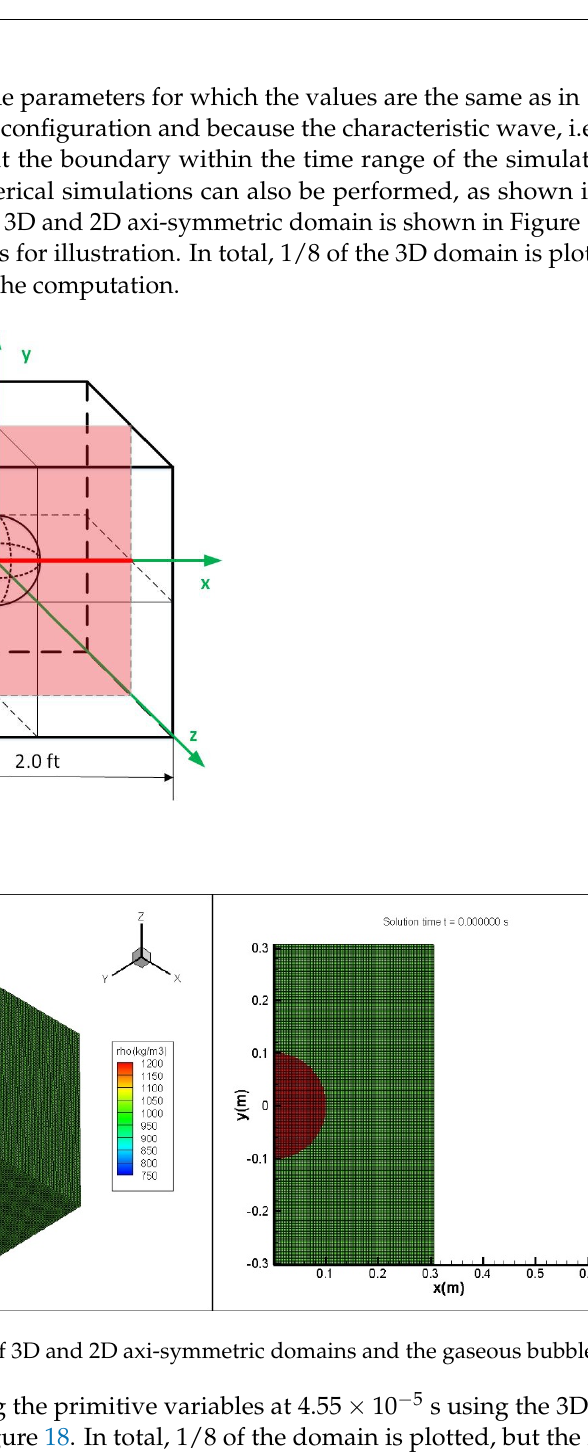
Figure 17. Discretization of 3D and 2D axi-symmetric domains and the gaseous bubble.